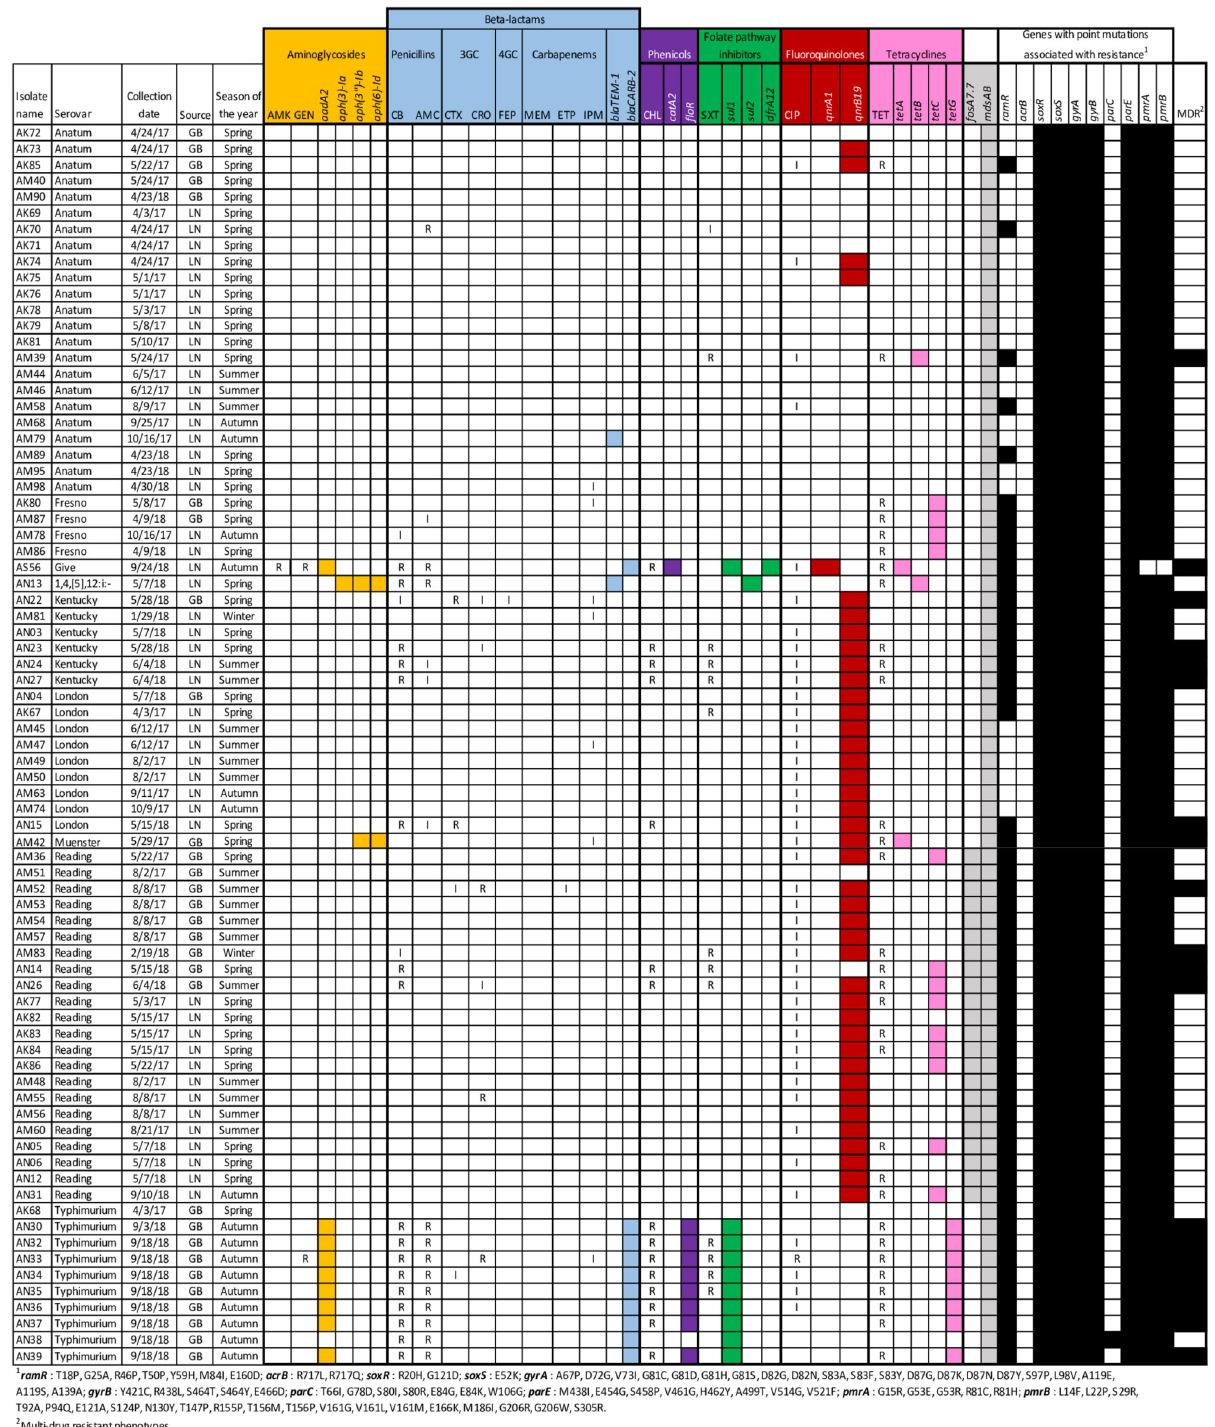
Fig 1. AMR profile of 77 Salmonella isolates from bovine Lymph Nodes (LN) and Ground Beef (GB). Within each antibiotic class, AMR phenotypes are first indicated, followed by AMR genes. Non-susceptible phenotypes are indicated with “R” (resistance) and “I” (intermediate resistance), while blank cells correspond to susceptible isolates. For AMR genotypes, cells filled with the corresponding antibiotic class color indicate the gene is present. AMR genes in gray are not associated with any antibiotic class included in the AST panel. Point mutations and MDR phenotypes are presented on the rightmost columns. Isolates with black cells have mutations/MDR phenotypes and those with blank cells lack these features. Antibiotic abbreviations are as follows: amikacin (AMK), gentamycin (GEN), carbenicillin (CB), amoxicillin-clavulanic acid (AMC), cefotaxime (CTX),